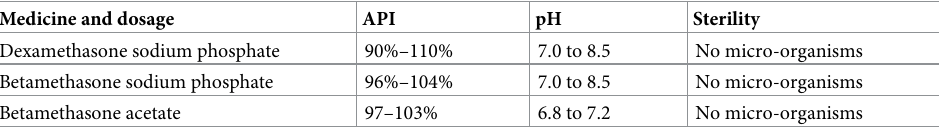
Table 1. Injectable dexamethasone and betamethasone quality parameters, based on International Pharmacopeia [25, 44] and US Pharmacopeia